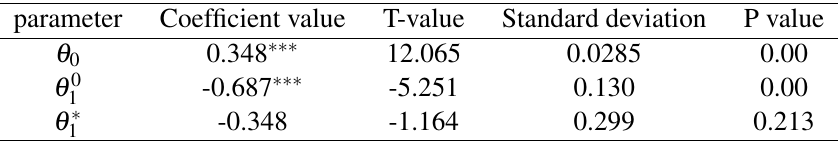
Table 3 Estimated Results of Equation